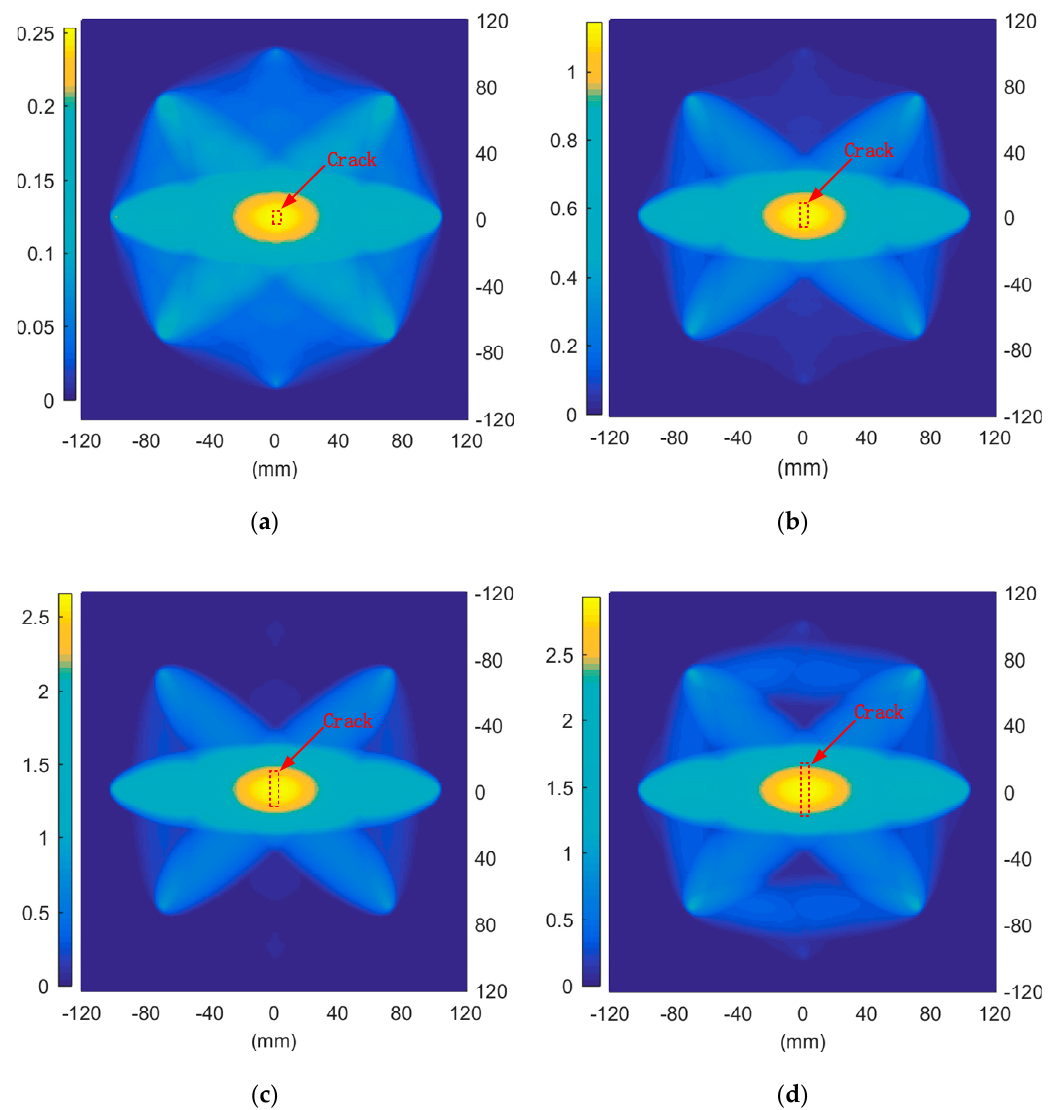
Figure 7. XY view of cracks of different lengths with inclination angle of 0° ( a ) 10 mm; ( b ) 20 mm; ( c ) 30 mm; ( d ) 40 mm.